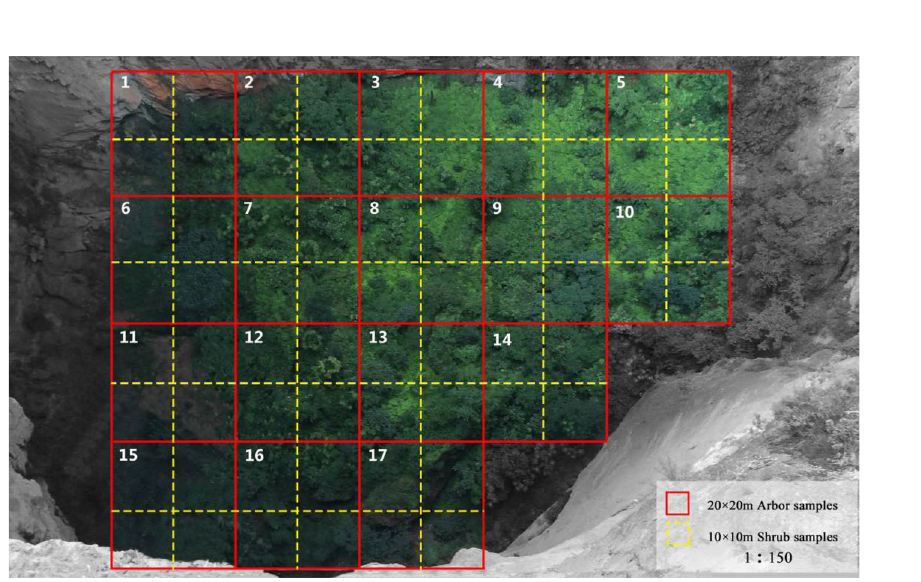
Figure 9. Plant community sample setting inside